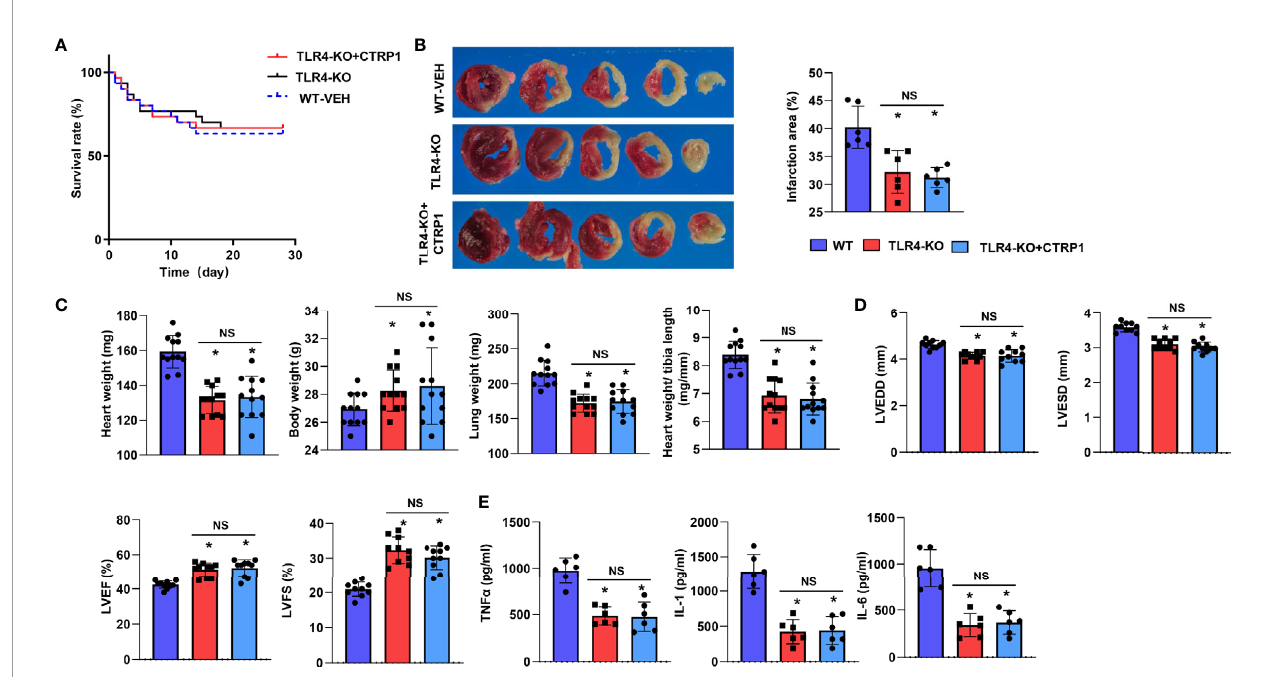
FIGURE 9 | TLR4 knockout counteracts the effects of CTRP1 in vivo. (A) The survival rate of TLR4 knockout mice receiving the human recombinant CTRP1 protein at 28 days post MI (n=30 per group). (B) TTC staining and quanti fi cation of the infarct area (n=6). (C) Heart, body, and lung weights of mice at 28 days post MI (n=12). (D) Echocardiography of mice at 28 days post MI (n=10). (E) In fl ammatory cytokine levels in heart tissue post MI (n=6). * P <0.05 vs. the WT-VEH group. NS, not signi fi